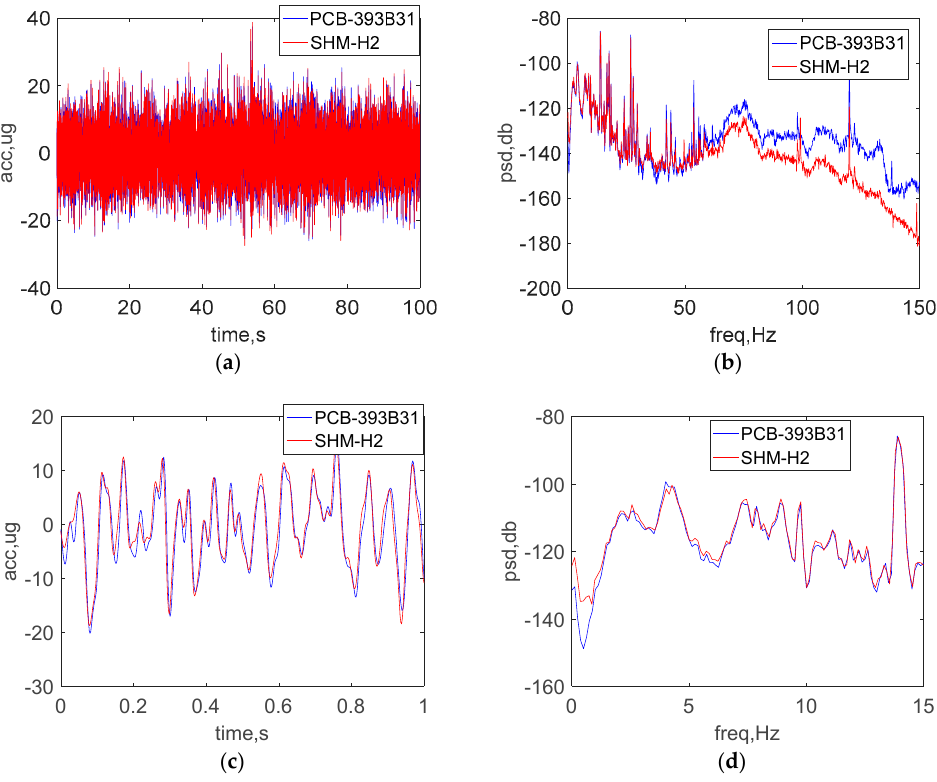
Figure 15. Test results on an optical table: ( a ) time history data ( b ) PSD data ( c ) zoomed view of time history data ( d ) zoomed view of low-frequency PSD data.